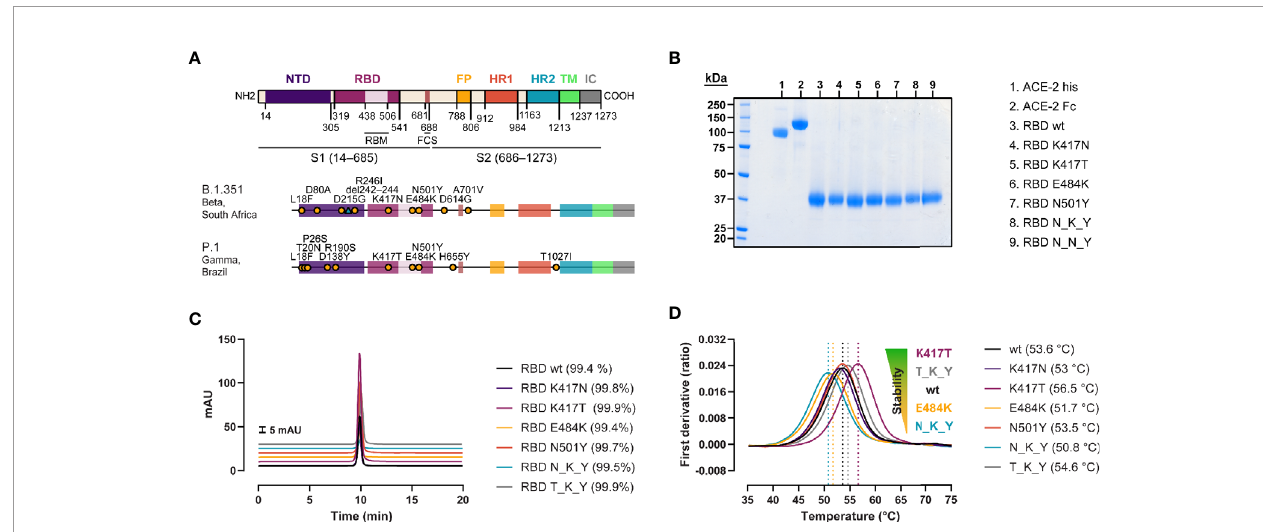
FIGURE 1 | Generation of recombinant SARS-CoV-2 RBD variants with B.1.351 and P.1 RBD mutations. (A) Domain organization of the spike protein gene (22, 23), and location of the B.1.351 and P.1 strain-de fi ning mutations (20, 21). NTD, N-terminal domain; RBM, receptor binding motif; FCS, furin cleavage site; FP, fusion peptide; HR1/2, heptad repeat 1/2; TM, transmembrane domain; IC, intracellular domain. (B) SDS-PAGE of the ACE-2 his-tagged and Fc-tagged used for the antibody-mediated neutralization assay and BLI measurements, respectively, and the biotinylated RBD variants under reducing conditions. (C) Purity determination by HPLC of the RBD variants. (D) Impact of the mutations on protein stability assessed by thermal denaturation experiments. Data are represented as the mean of the fi rst derivative of the 350nm:330nm fl uorescence ratio from 3 capillaries. Local maxima, signaled by vertical dashed lines, represent the in fl ection temperatures